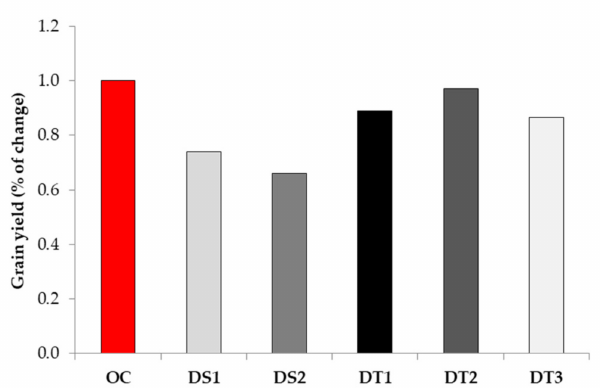
Figure 3. The percentage of changes for grain yield under water deficit stress (non-irrigation treatment—I 0 ) compared to the optimal conditions (irrigation treatment—I 75 ) evidenced in drought tolerant (DT1, DT2, and DT3) and drought susceptible (DS1 and DS2) inbreds. OC—values measured under optimal conditions given as 1